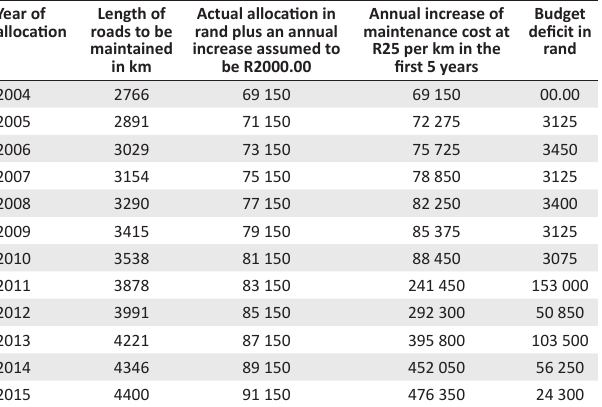
TABLE 4: Roads maintenance budget deficit in Makhado municipality 2004–2014.